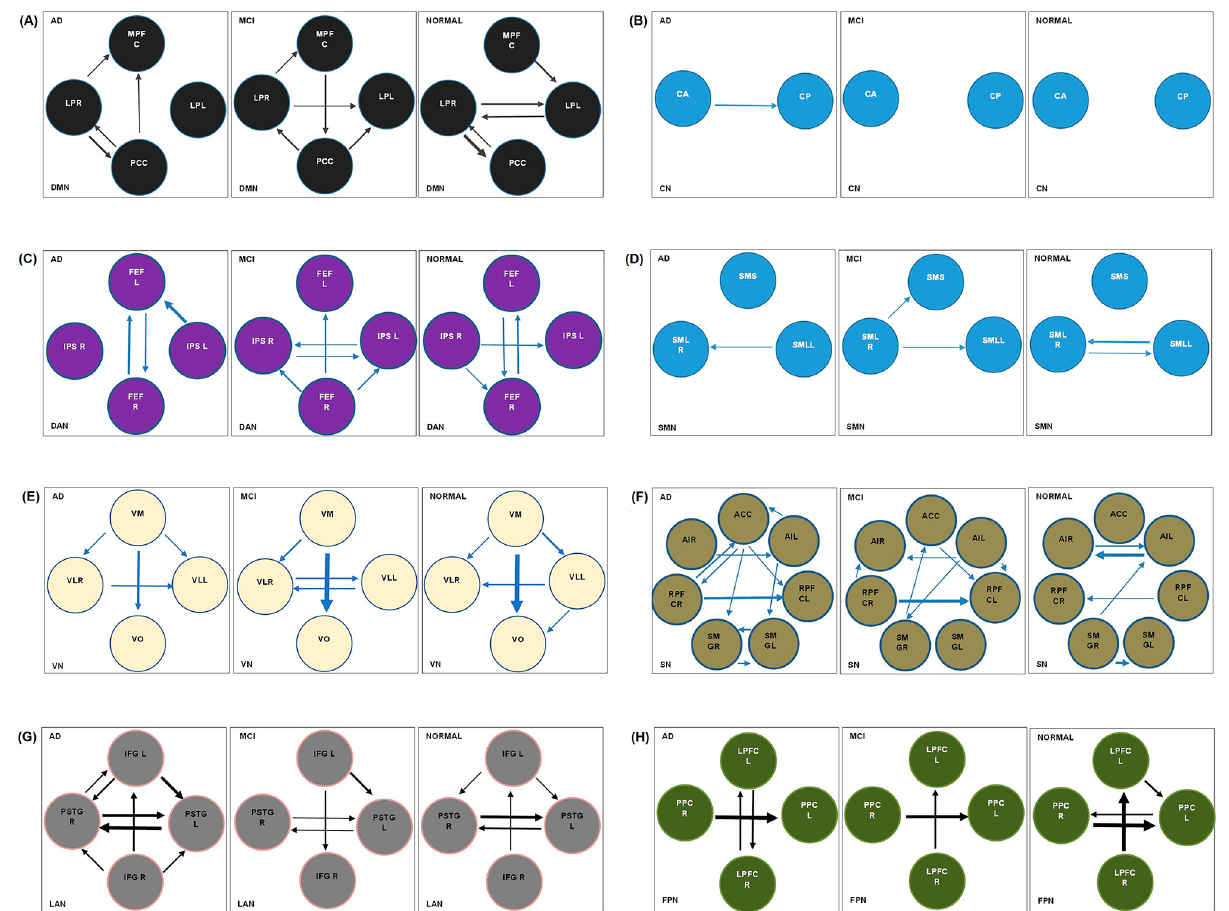
Figure 3. Effective connectivity patterns of AD, aMCI, and normal group in resting-state networks extracted from the spectral DCM analysis. The arrow’s direction shows the direction of causal influences, and its thickness shows the strength of the connection. The circle refers to the nodes of each resting-state network. Only connection strengths greater than 0.05 Hz are displayed (see Tables S2–S9): ( A ) default mode network: medial prefrontal cortex (MPFC), left lateral parietal (LP(L)), right lateral parietal (LP(R)), and posterior cingulate cortex (PCC); ( B ) cerebellar network: anterior cerebellar (CA), posterior cerebellar (CP); ( C ) dorsal attention network: left frontal eye field (FEFL), right frontal eye field (FEFR), left intraparietal sulcus (IPS(L)), right intraparietal sulcus (IPS(R)); ( D ) sensorimotor network: Left lateral sensorimotor (SML(L)), right lateral sensorimotor (SML(R)), superior sensorimotor (SMS); ( E ) visual network: visual medial (VM), visual occipital (VO), left lateral visual (VLL), and right lateral visual (VLR); ( F ) salience network: anterior cingulate cortex (ACC), left anterior insula (AlL), right anterior insula (AIR), left rostral prefrontal cortex (RPFCL), right rostral prefrontal cortex (RPFCR), left supramarginal gyrus (SMGL), right supramarginal gyrus (SMGR); ( G ) language network: left inferior frontal gyrus (IFGL), right inferior frontal gyrus (IFGR), left posterior superior temporal gyrus (pSTGL), right posterior superior temporal gyrus (pSTGR) ( H ) frontoparietal network: Left lateral prefrontal cortex (LPFCL), left posterior parietal cortex (PPCL), right lateral prefrontal cortex (LPFCR), right posterior parietal cortex (PPCR).